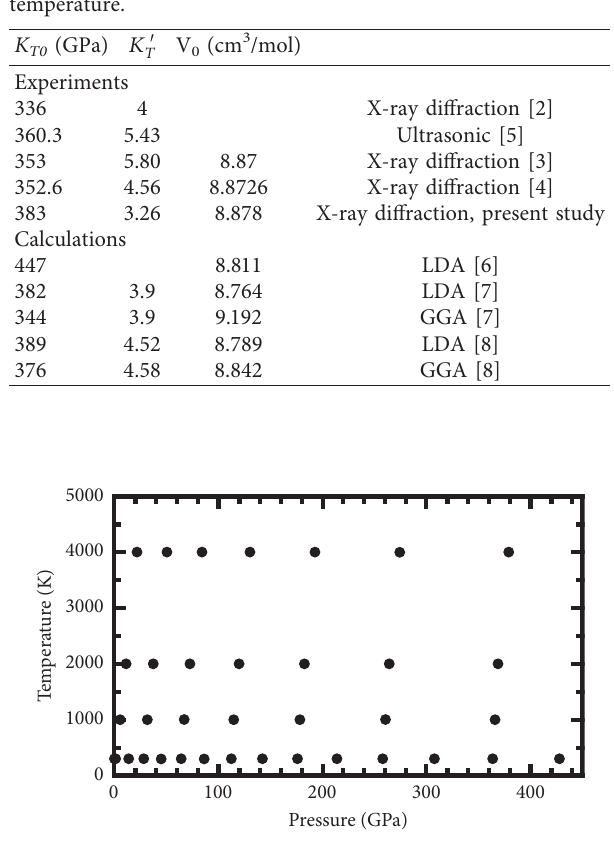
Figure 3: Pressure-temperature conditions under which first- principles molecular dynamics was